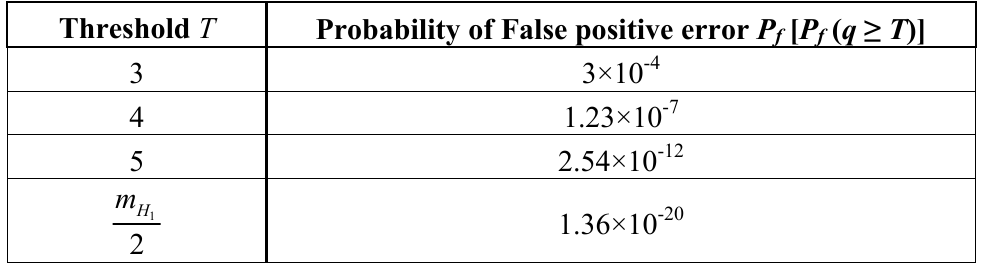
, associated to the acceptance threshold T . f